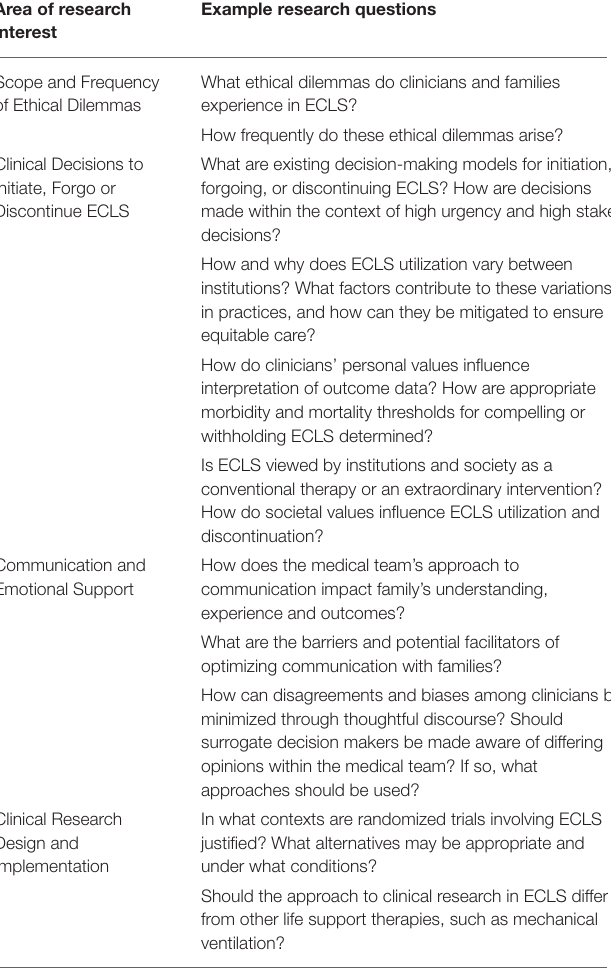
TABLE 2 | Research agenda: example questions to address through normative and empirical